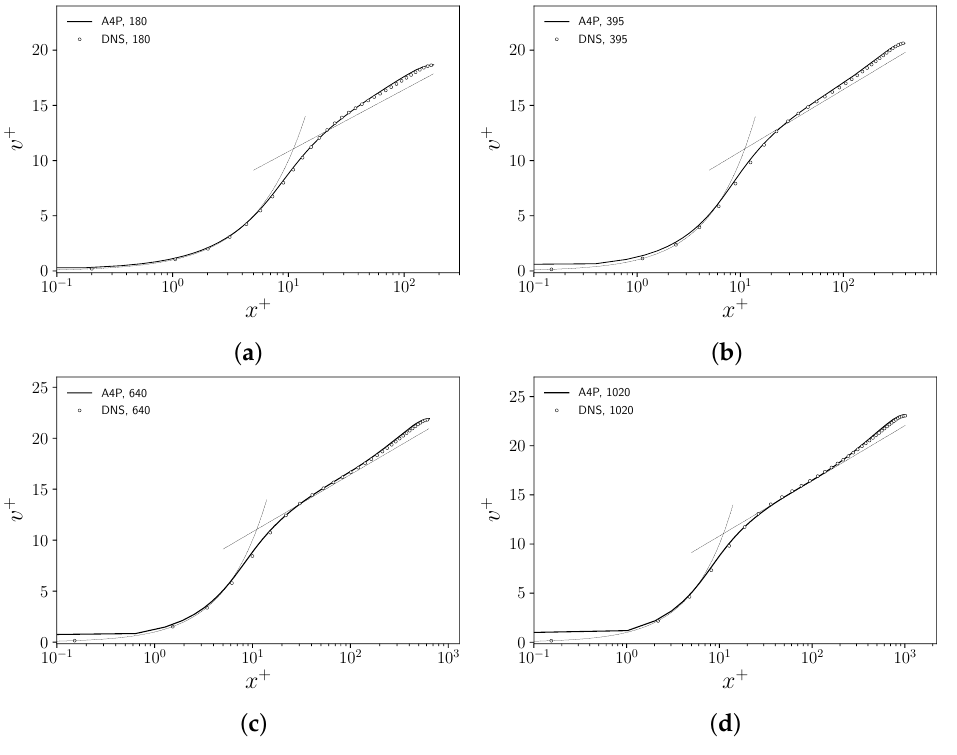
Figure 2. Non-dimensional streamwise velocity v + for Re τ = 180 ( a ), 395 ( b ), 640 ( c ), and 1020 ( d ). DNS data from